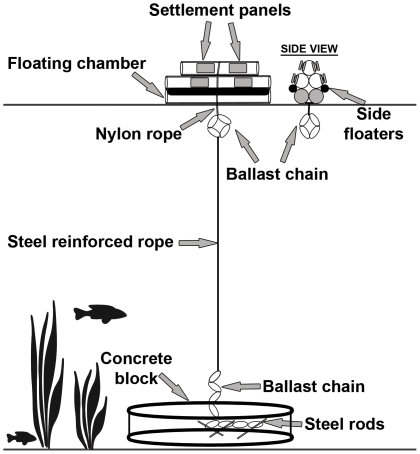
Schematic representation of an artificial island.